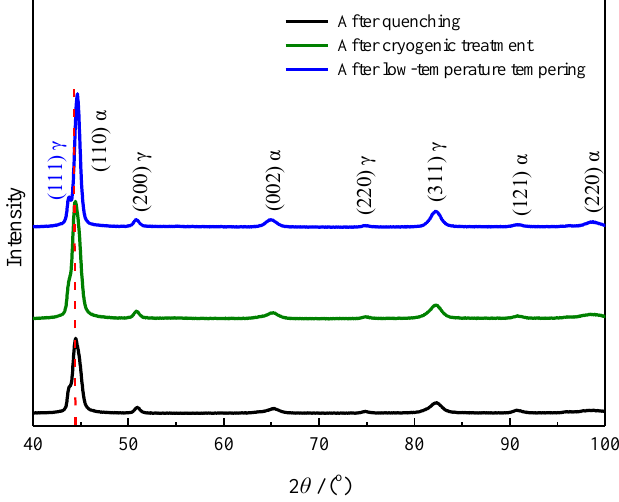
Figure 14. XRD patterns of the carburized layer at a 0.3 mm depth for process 2.